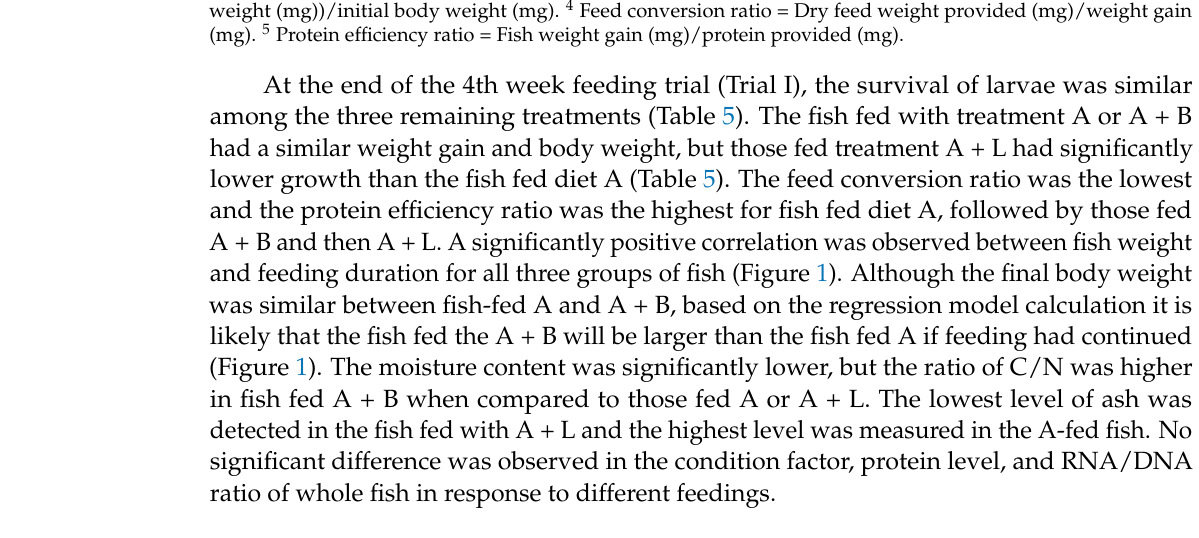
Table 5. Growth performances and whole-body proximate composition of lake sturgeon fed with different diets for 4 weeks (Trial I) 1